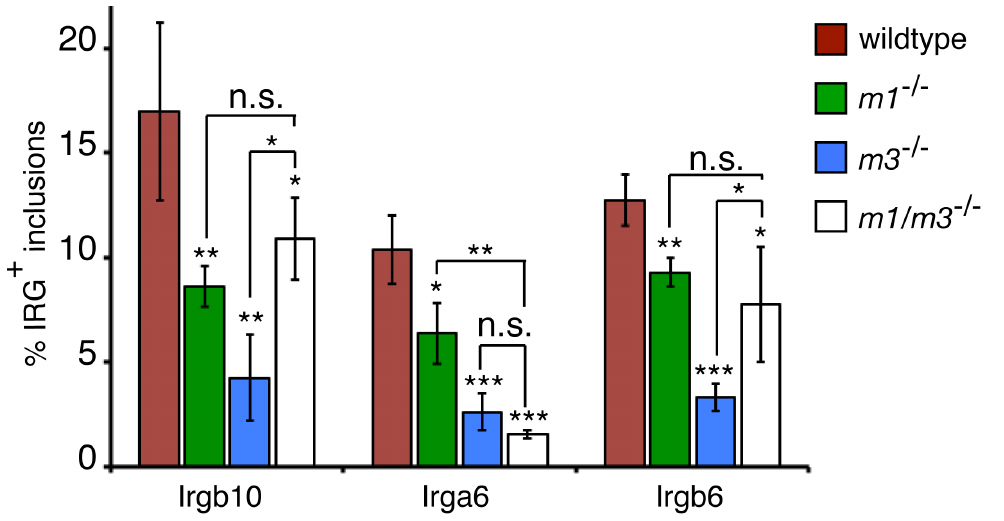
Figure 3. Irgm1 and Irgm3 are critical co-factors for targeting the GKS proteins Irgb10, Irga6 and Irgb6 to C.trachomatis inclusions. MEFs were infected with C. trachomatis and media + / 2 IFN c at 100 U/ml was replaced at 3 hpi. Cells were fixed at 20 hpi and stained with anti- C. trachomatis and anti-GKS antibodies. The frequency of GKS-positive inclusions is shown in MEFs of the indicated genotypes. Graph represents average values 6 SD. Data are representiaitve of three independent experiments. Statistical significance of group values relative to wildtype and between marked groups are shown (*, p , 0.05; **, p , 0.01; and ***, p , 0.005).